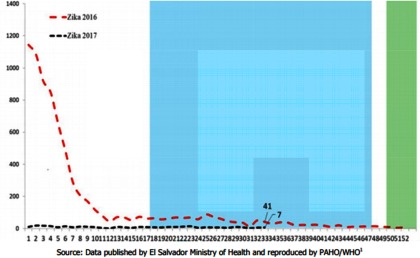
Suspected and Confirmed Zika Cases, El Salvador, Epidemiological Week 1 of 2016 to Epidemiological Week 33 of 2017Source: PAHO and WHO (2017).10